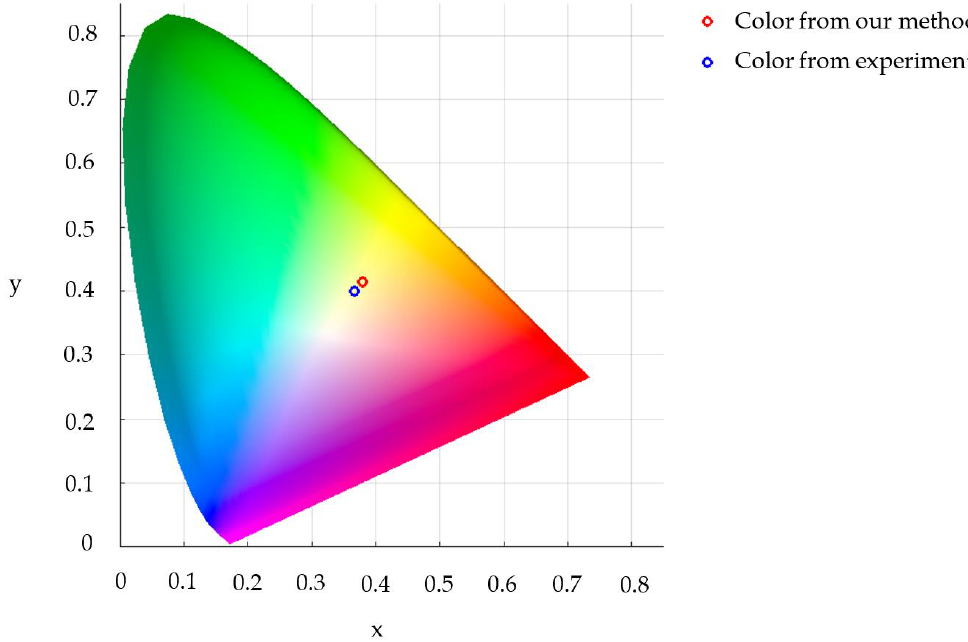
Figure 14. The CIE chromaticity diagram with mapping comparison from our proposed method and the measured color of photograph at laser intensity (2nd scan) 200 J/cm 2 from [38]. The CIE chromaticity diagrams in Figures 12–14 show colors as they would appear when viewed by the naked eye. The diagram divides color groups into regions on the diagram. Similar colors are close to each other in the same region. The dots in the figures show a comparison between the colors from the experiment and our proposed technique. The locations of these points are in the same color shade. In other words, the results show that the dots from our proposed method lie in close proximity to the ones from Kuroiwa’s technique. This implies that our method can accurately convert transmittance to actual colors. We also learn that sampling only specific wavelengths (RGB) when analyzed with our technique can predict the overall characteristics of the transmittance curve. This tech- nique can be applied to complex tasks that require a lot of effort to calculate or measure the transmittance characteristic. By calculating or measuring just three wavelengths (RGB), transmittance across the visible light regime can be mapped to true colors, without the need for all the transmittance values across the entire VIS regime. 4. Conclusions and Future Work This paper proposes a design of an anti-counterfeiting security film based on a fre- quency-selective surface (FSS). Our film can display different colors on each side of the film and the colors are swapped when the film is reversed, due to the film’s FSS behavior. In this design, aluminum nanoparticles are arranged in an array on a two-dimen- sional plane that is embedded in PET. This arrangement allows us to adjust the wave- lengths based on the separation distance, as well as the dimension of the cubes. The per- formance of the film is evaluated by an FEA method. The parametric studies show that the nanocube’s width (W) and length (L) are the critical parameters in the film design. By adjusting the size of the nanocube appropriately, it is possible to obtain the transmittance characteristic that changes the color of the light when passing through or reflecting off the film. The condition requires that the size of the nanocube must be smaller than the wavelength of the incident light. This technology has a low cost when it is mass produced. It has a simple structure and the color-changing